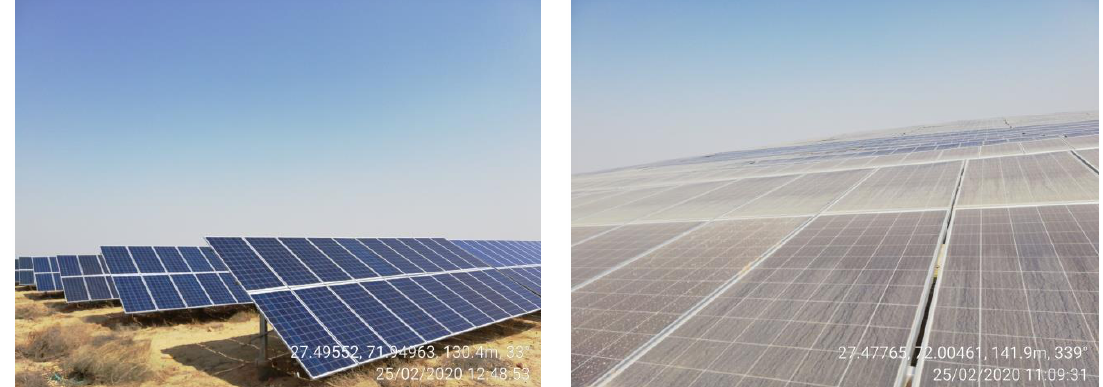
Figure 4. ( a ) Photographs showing the photovoltaic solar panels during the clean condition and ( b ) during the sandy deposition stage in the Bhadla Solar Park, Jodhpur District, Rajasthan State, India.